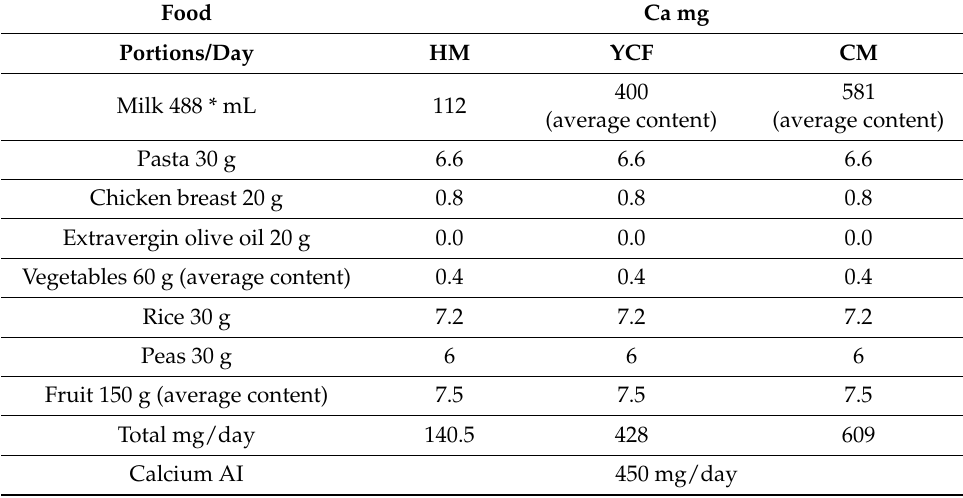
Table 7. Different Ca intakes for an infant of around 18 months of age weighing approximately 10.2–10.9 kg [32] when breastfed, fed with YCF or CM, using a single scheme of intake of solid